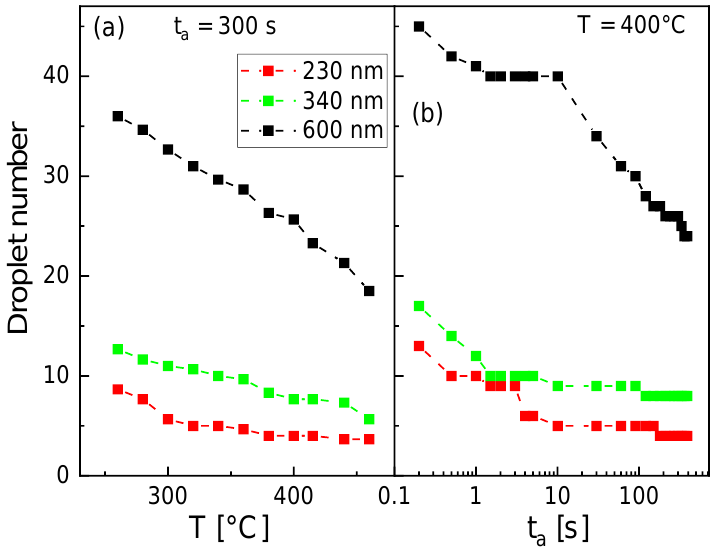
Figure 7. Simulated droplet number after annealing ( a ) as a function of annealing temperature T and ( b ) as a function of the annealing time t a for different aperture diameters d